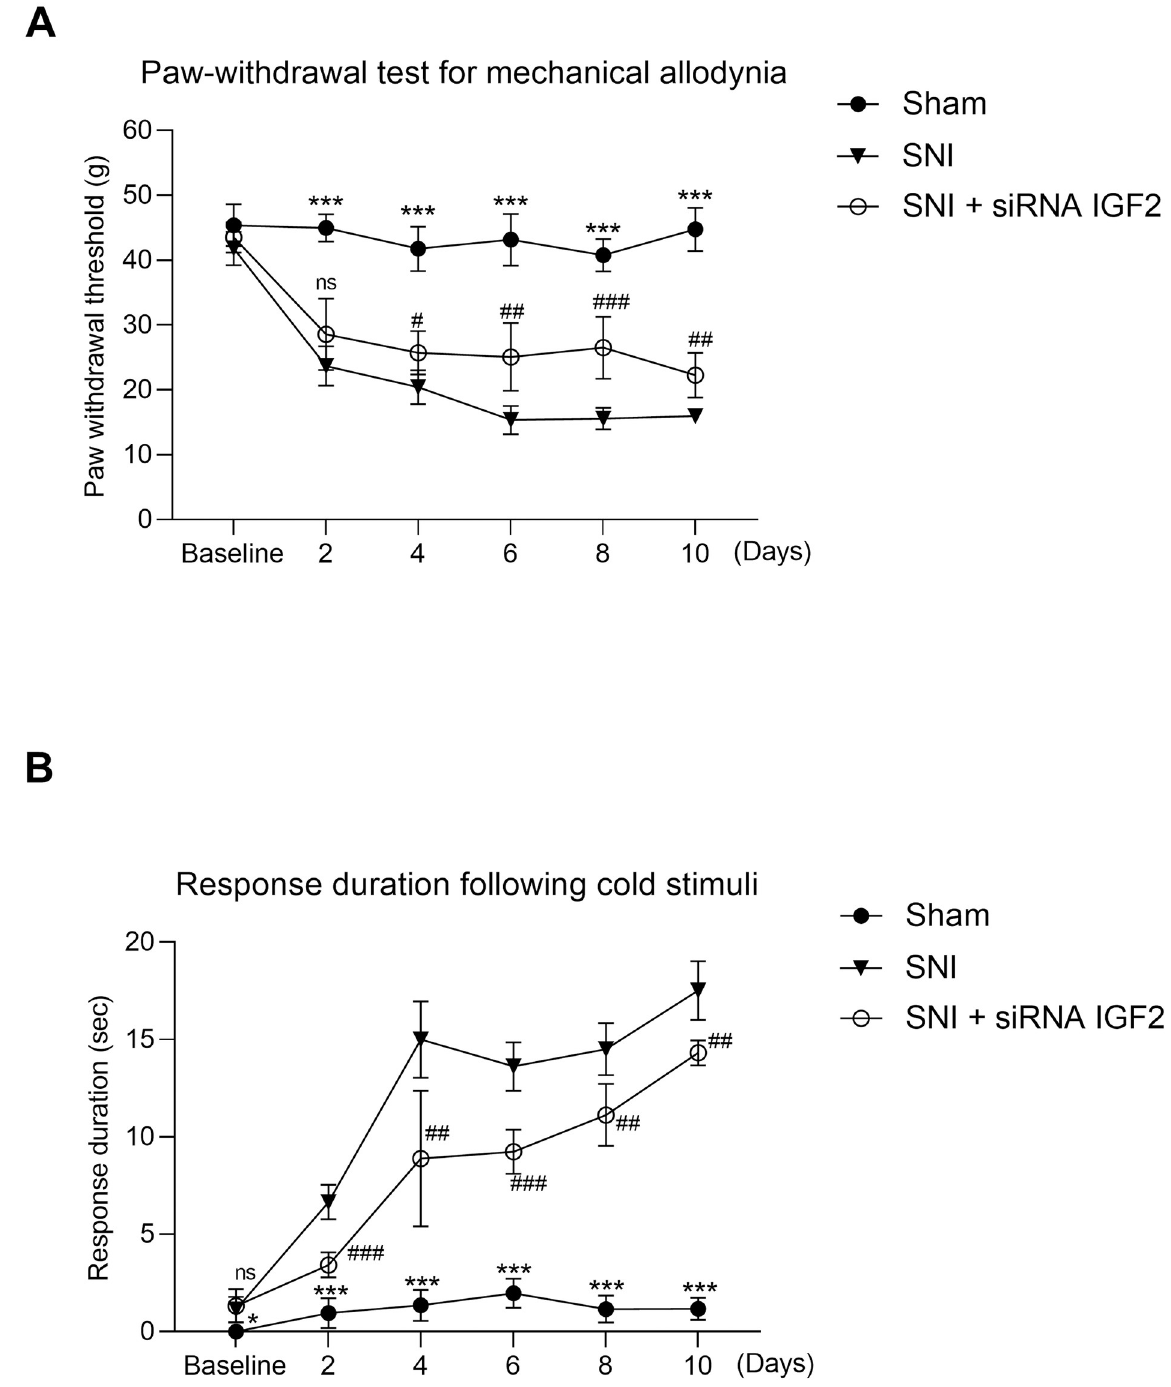
Fig 2. Effect of intrathecal injection of IGF2 siRNA on rat behavior. Rats are randomly divided into three groups (n = 6 per group): sham (normal saline solution) group ( ● ); SNI group (normal saline solution) ( ▼ ); SNI + siRNA IGF2 group ( ○ ). A . Paw-withdrawal test for mechanical allodynia. Mechanical allodynia is examined using a dynamic plantar aesthesiometer in the three groups. SNI versus sham ��� P < 0.001; SNI + siRNA IGF2 # P < 0.05, ## P < 0.01, ### P < 0.001. B . Response duration following cold stimuli using an acetone spray test in the three groups. SNI versus sham � P < 0.05, ��� P < 0.001; SNI + siRNA IGF2 # P < 0.05, ## P < 0.01, ### P < 0.001. Each point represents the mean ± SD. The data presented above were examined by two-way repeated measures ANOVA followed by Bonferroni post hoc comparisons. SNI, spared nerve injury; siRNA, small-interfering RNA; IGF2, insulin-like growth factor-2; ns, not significant.